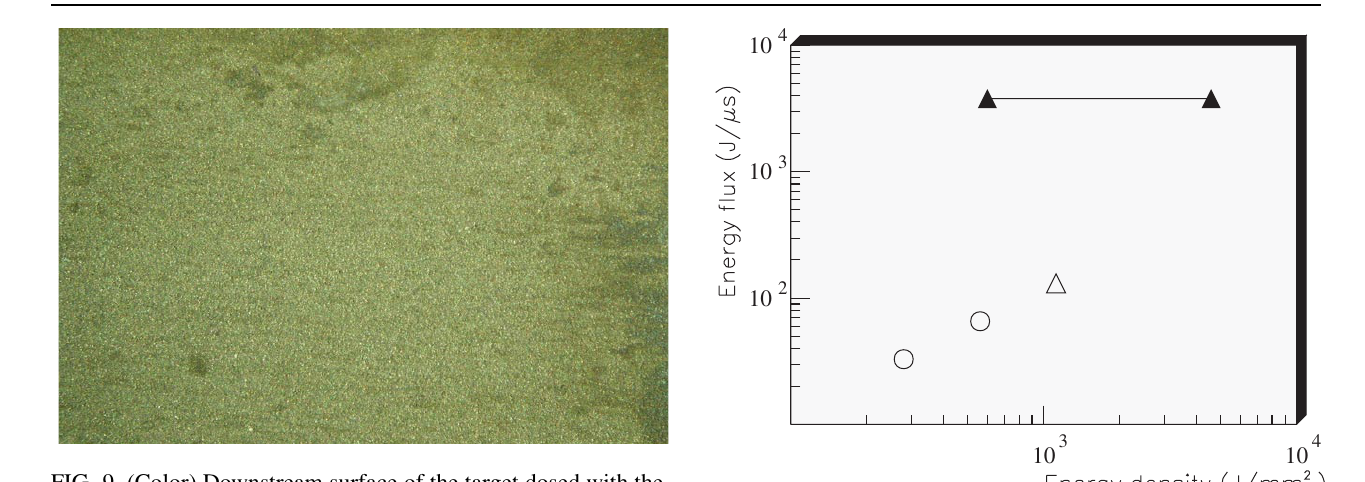
FIG. 9. (Color) Downstream surface of the target dosed with the ILC0.7 mode (target 4). The horizontal size of this picture corresponds to 10 mm. No trace was observed at all on the target surface. There was no indication of changes on the thermal paper. A clear black spot on the developing paper, as shown in Fig. 4, is evidence that the beam passed through the target.